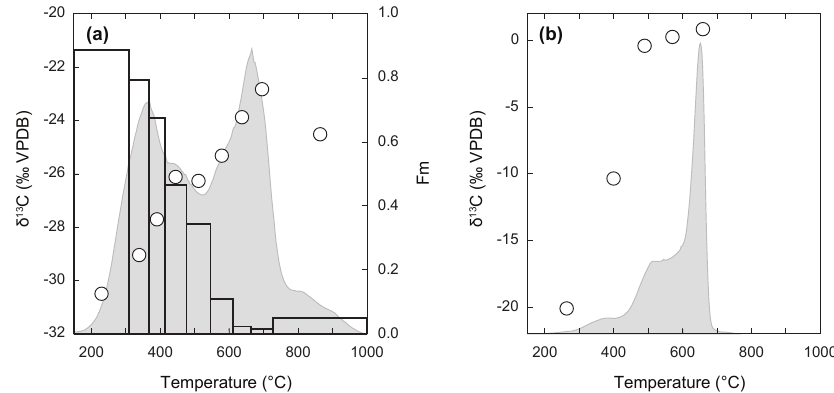
Figure 2. RPO results. Measured thermograms (gray shaded region, ppmCO 2 axes not shown), δ 13 C values (white circles, left axes), and Fm values (transparent bars, right axes) for (a) Narayani POC and (b) JGOFS sediment (Fm not measured). Fm bar widths correspond to the temperature range of collection for each RPO fraction. Fm and δ 13 C analytical uncertainty is always smaller than point marker and is therefore not shown (see Tables 2–3 for